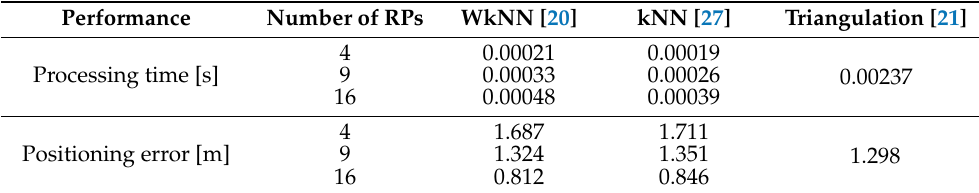
Table 2. Comparison between proposed and conventional scheme.